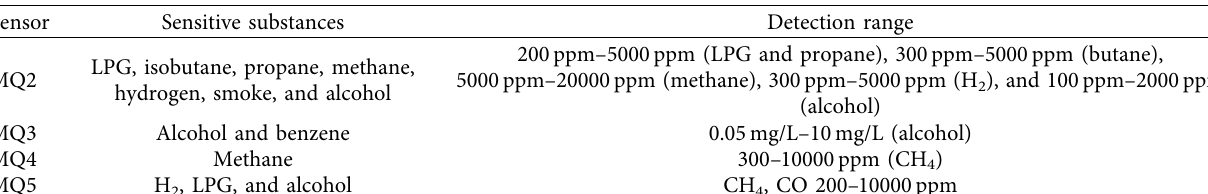
Table 1: Sensors used in the sensor array.